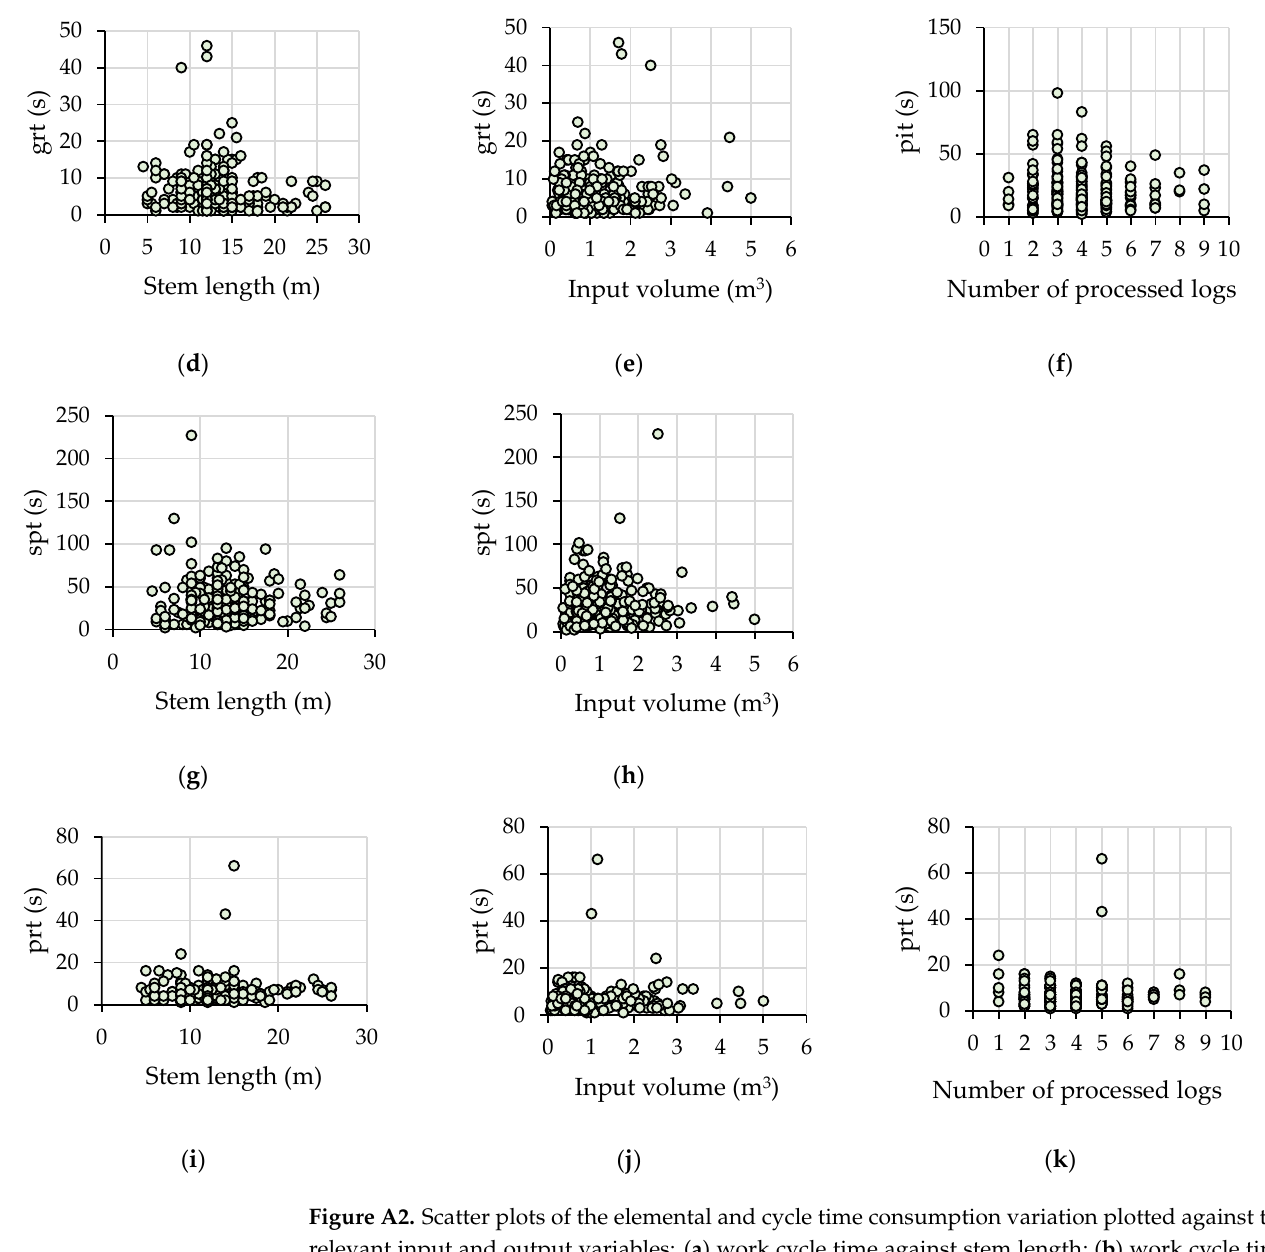
Figure A2. Scatter plots of the elemental and cycle time consumption variation plotted against the relevant input and output variables: ( a ) work cycle time against stem length; ( b ) work cycle time against input volume; ( c ) work cycle time against number of processed logs; ( d ) grabbing time against stem length; ( e ) grabbing time against input volume; ( f ) piling time against number of processed logs; ( g ) swinging to process time against stem length; ( h ) swinging to process time against input volume; ( i ) processing time against stem length; ( j ) processing time against input volume; ( k ) processing time against number of processed logs; Note: data have failed normality and homoskedasticity assumptions, and no trends were found to build suitable models by